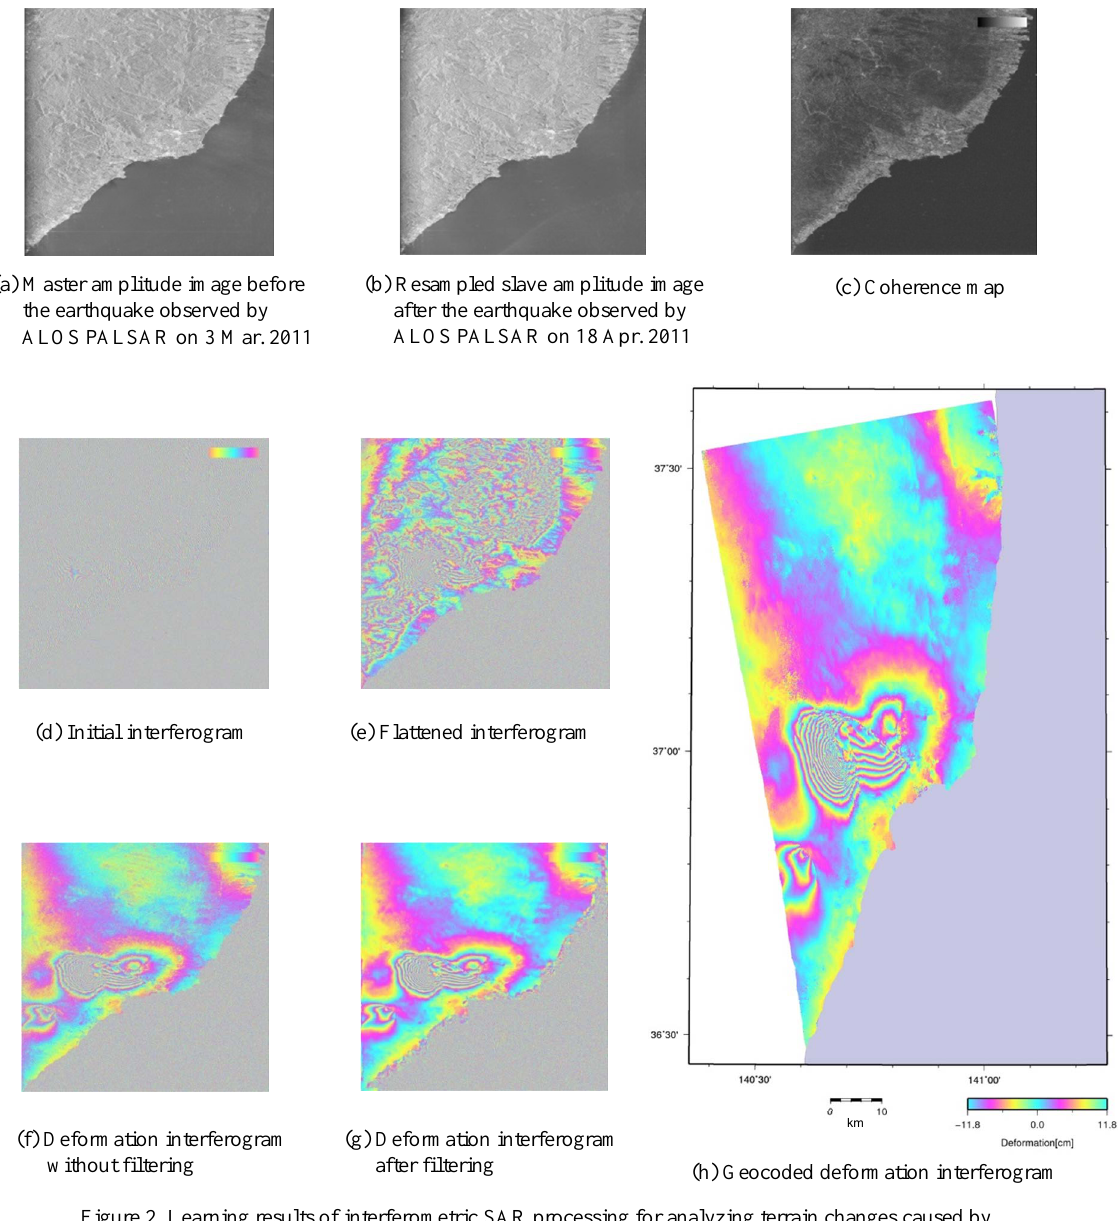
Figure 2. Learning results of interferometric SAR processing for analyzing terrain changes caused by event No. 7 in Table